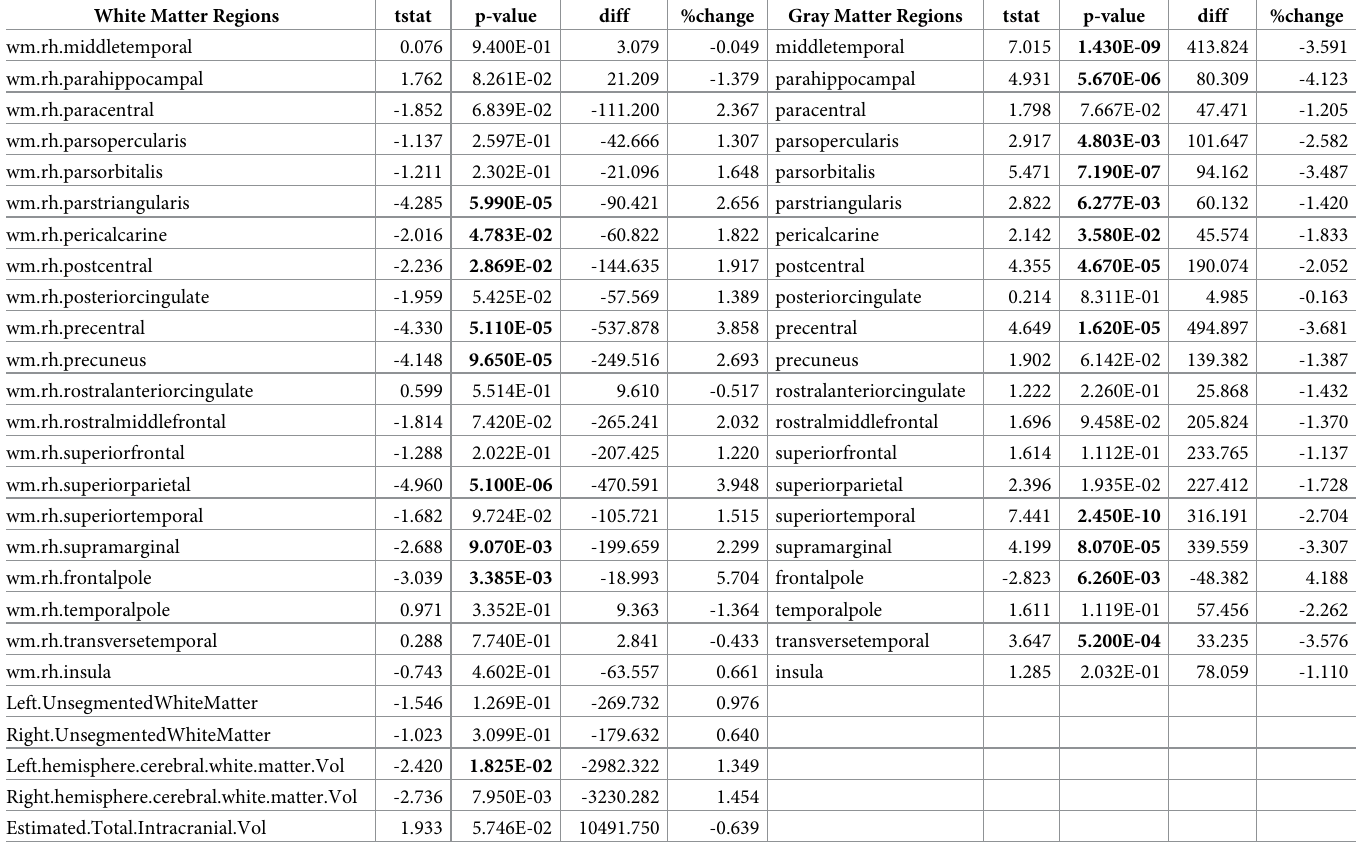
the veins. Astrocytic endfeet cover almost the entire brain vasculature regulating endothelial tight junctions that form the blood brain barrier as well vascular tone through vasoactive agents [34]. Astrocytic endfeet also express water channels called aquaporin-4 (AQP4); these Table 6. Comparisons of ventricular size during anesthesia (A2) and day 7.